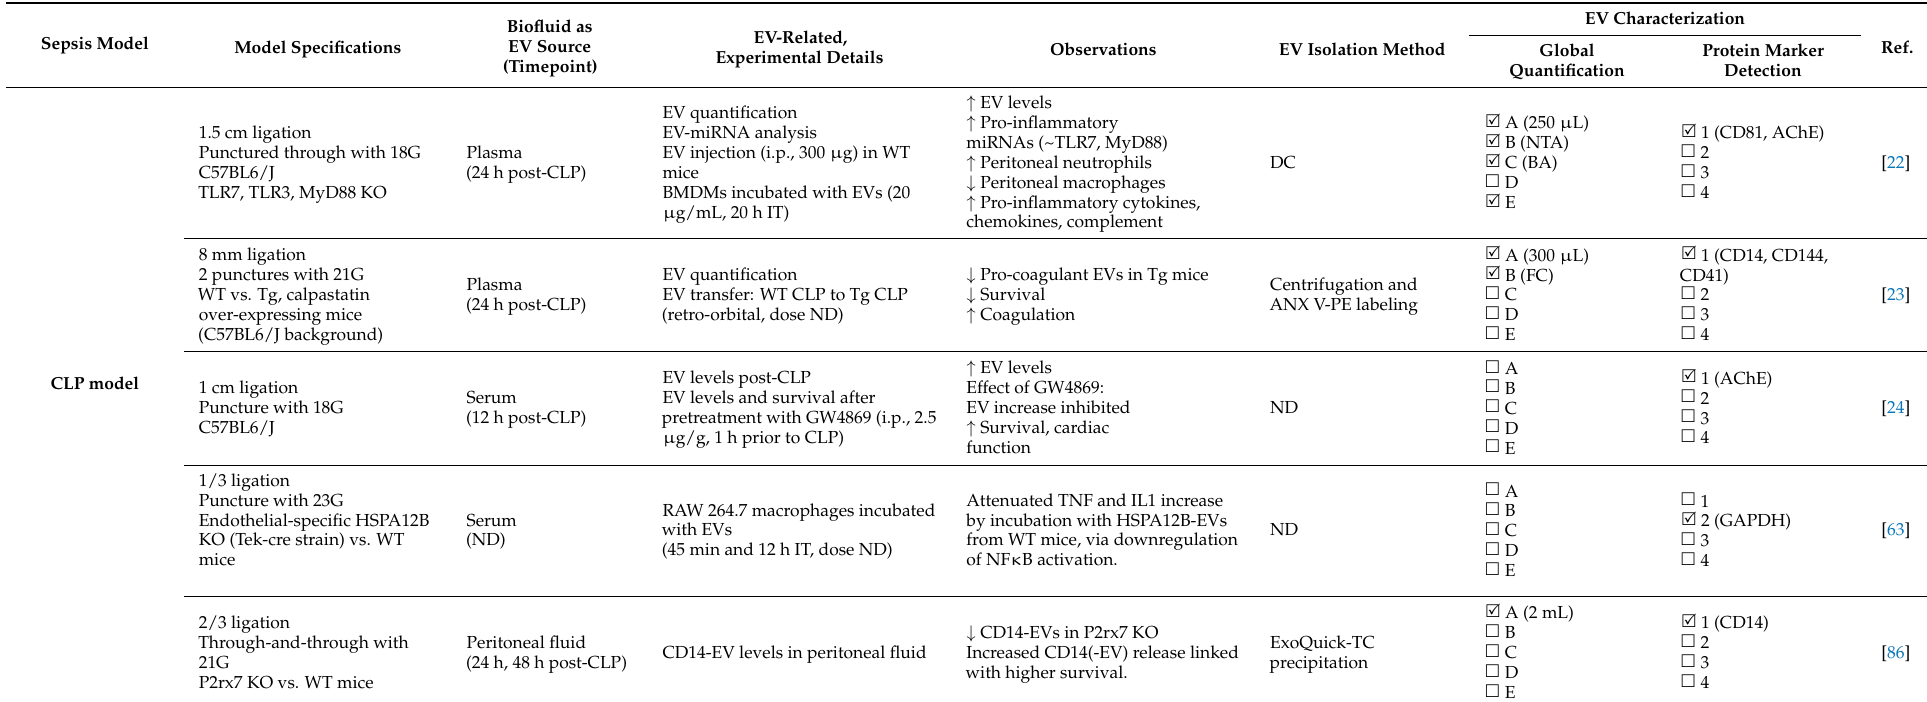
Table 2. Minimal Information for Studies of EVs (MISEV) guideline-related information about EV isolation and characterization in the studies discussed in this review, investigating mouse-derived EVs. For global quantification requirements, consult checkboxes A–E. Checkbox A: Cell number/fluid volume/tissue mass from which EVs were isolated. Checkbox B: Analysis of particle number. Checkbox C: Analysis of protein amount. Checkbox D: Analysis of lipid amount. Checkbox E: Analysis by electron microscopy. For information regarding protein marker detection, consult checkboxes 1–4. Checkbox 1: Transmembrane or Glycosylphosphatidylinositol (GPI)-anchored protein(s) localized in cells at plasma membrane or endosomes. Checkbox 2: Cytosolic protein(s) with membrane-binding or -association capacity. Checkbox 3: Assessment of presence/absence of expected contaminants. Checkbox 4: For small EVs < 200 nm: verifying protein(s) associated with compartments other than plasma membrane or endosomes. Abbreviations: extracellular vesicle (EV), not described (ND), incubation time (IT), culture medium (CM), cerebrospinal fluid (CSF), bone marrow derived macrophages (BMDMs), transgenic (Tg), wildtype (WT), knock-out (KO), cecal ligation and puncture (CLP), lipopolysaccharide (LPS), Toll-like receptor (TLR), Escherichia coli ( E. coli ), brain microvascular endothelial cells (BMECs), choroid plexus (CP), intravenous (i.v.),